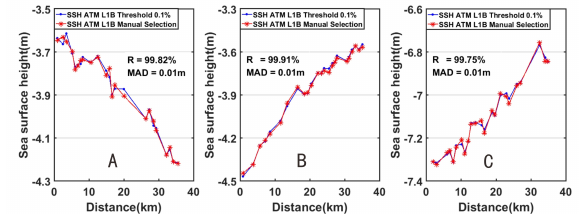
Figure 3. Under improvements method, Sea surface heights derived from L1B manual selection and the threshold of 0.1% method over DMS images with leads along the flight direction (C to A), respectively for A, B and C